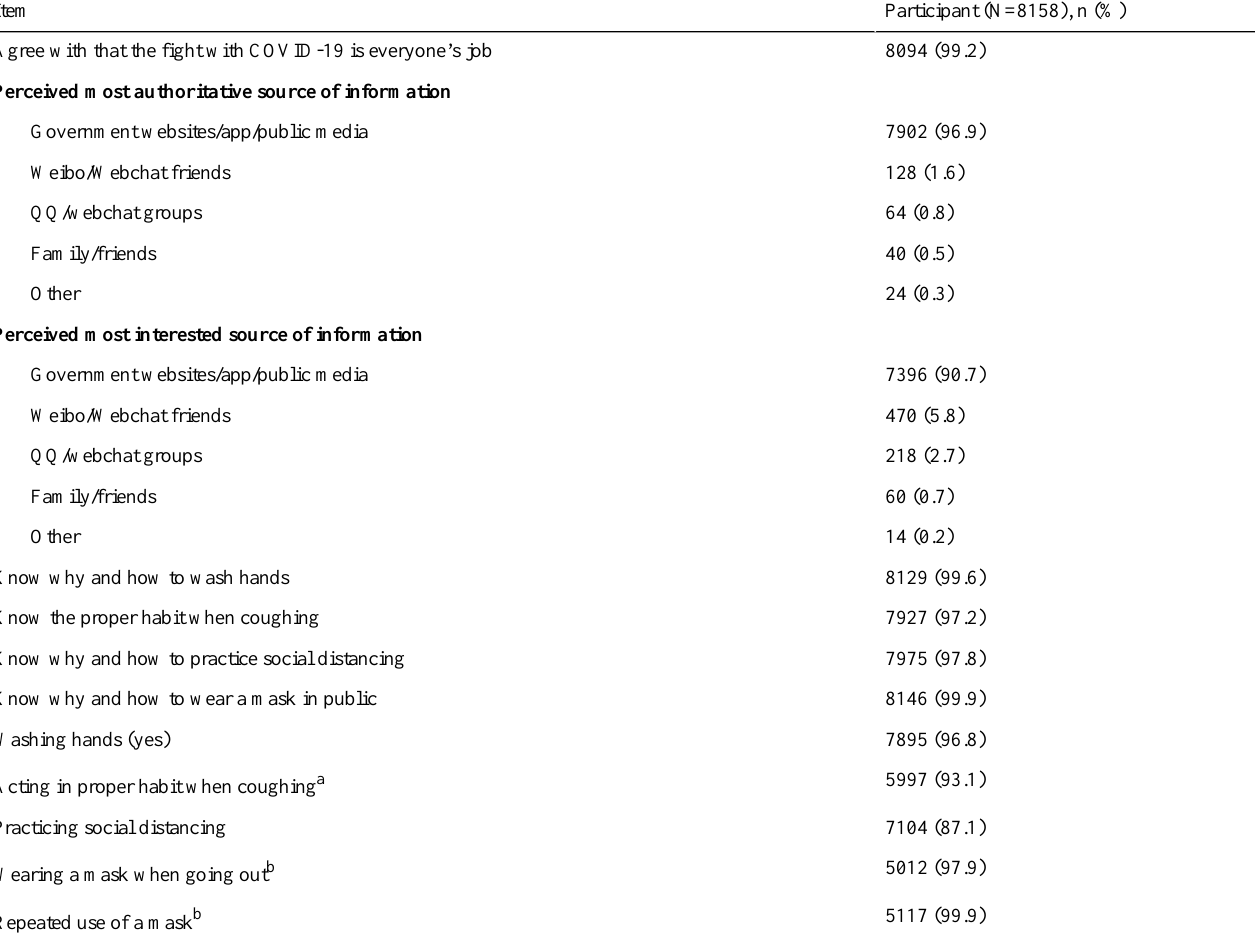
Table 3. Attitude, source of information, knowledge, and the four nonpharmaceutical interventions.